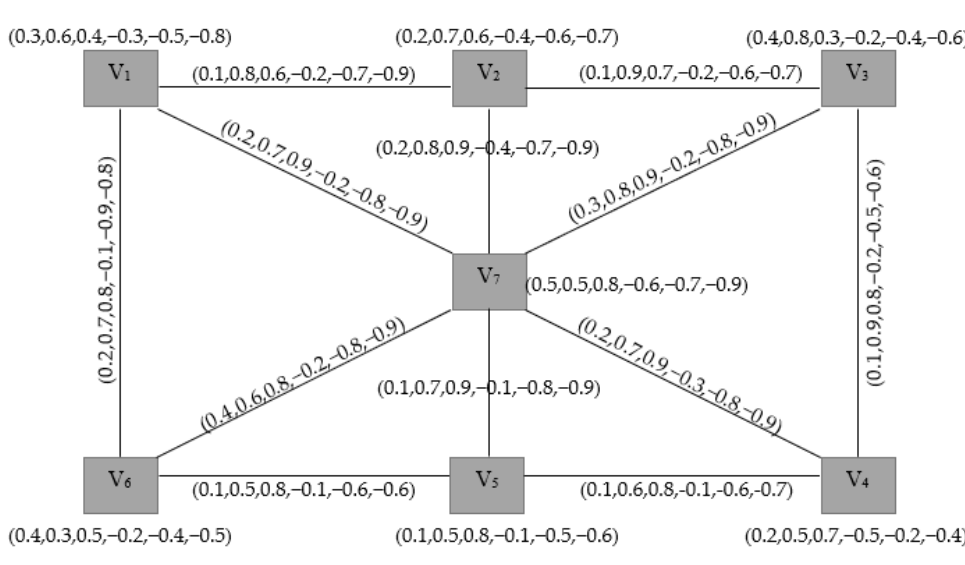
Figure 2. Laplacian energy a of bipolar single-valued neutrosophic graph. The adjacency, degree and the Laplacian matrices of the BSVNG shown in Figure 2 are given as follows: